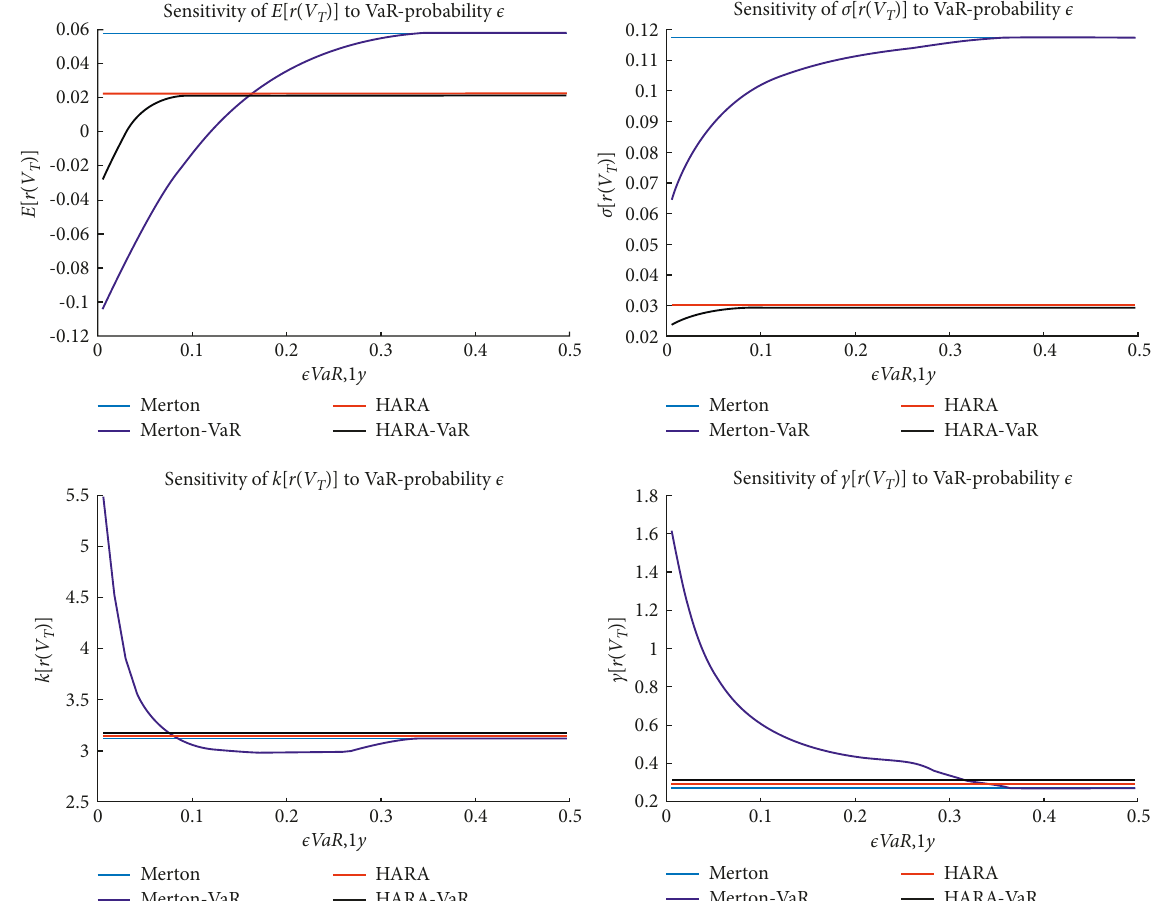
Figure 1: First four moments of sensitivity to ϵ